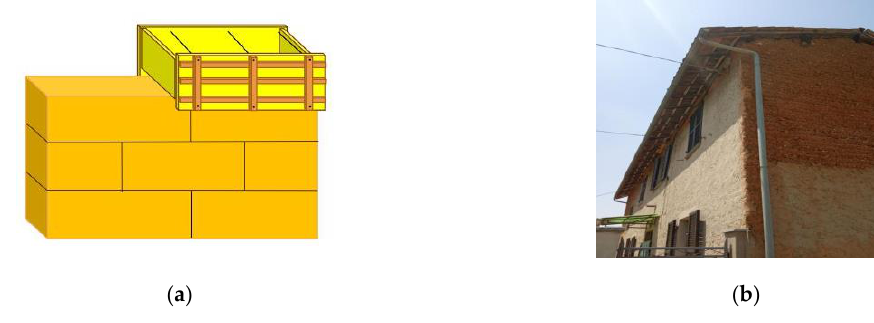
Figure 1. Rammed earth. ( a ) Schematic illustration and ( b ) a rammed earth house.